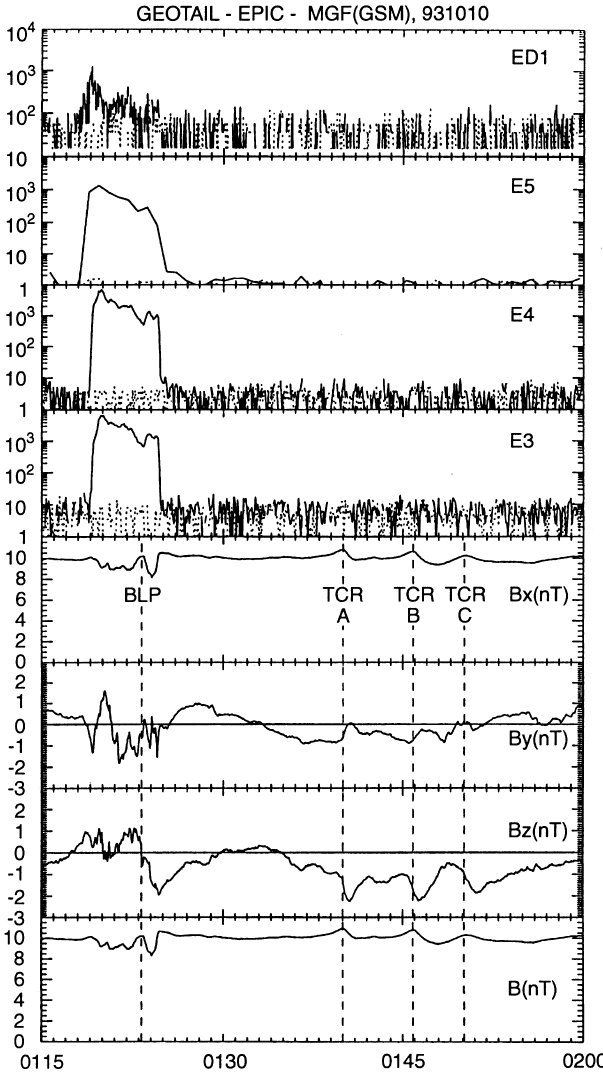
Fig. 5. An expanded overview of the time interval 0115 UT – 0200 UT, where a boundary layer plasmoid (BLP) is observed following by three travelling compression regions (TCR). The dashed vertical lines are drawn through the centre of the BLP and of the